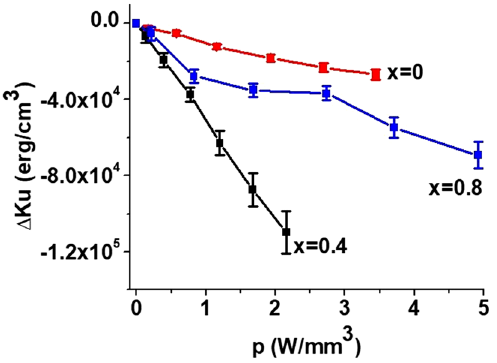
Figure 9. Dependence of the uniaxial anisotropy energy constant as a function of applied electric power density in SrAlM hexaferrites.